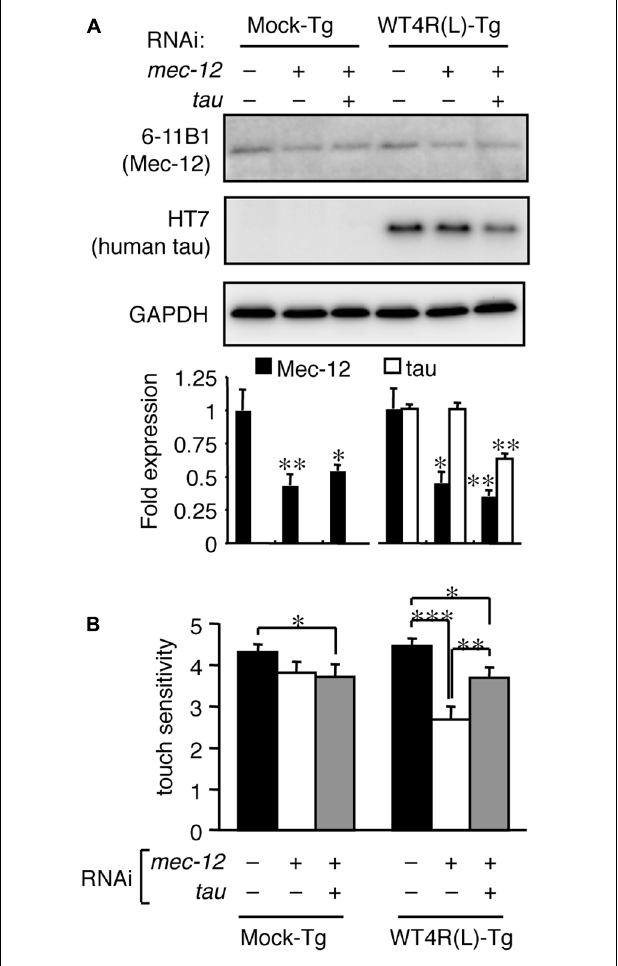
FIGURE 4 | Tau reduction rescues the neuronal dysfunction induced by tubulin knockdown. Mock-Tg/rrf-3 and WT4R(L)-Tg/rrf-3 worms were grown on L4440::T, L4440::mec-12 + L4440::T, or L4440::mec-12 + L4440::tau RNAi plates from embryo to 4 days after hatch. (A) Expression levels of MEC-12, tau and GAPDH were quantified by Western blotting. Lower panel showed the relative expression of Mec-12 and tau against naive worms (means ± SEM, n = 4). (B) The average number of responses per 5 trials of anterior touch are shown (means ± SEM, n = 80). The touch-sense abnormality of WT4R(L)-Tg/rrf-3 induced by mec-12 RNAi was significantly reduced by co-administering tau RNAi. Statistical significance was analyzed by Tukey’s post hoc test ( ∗ p < 0.05 , ∗∗ p < 0.01 , and ∗∗∗ p < 0.001